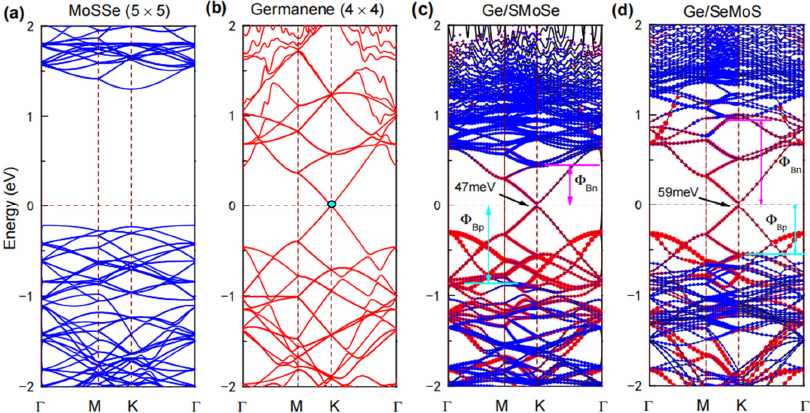
Figure 2. The band structures of ( a ) (5 × 5) MoSSe, ( b ) (4 × 4) germanene, ( c ) Ge/SMoSe and ( d ) Ge/SeMoS heterostructures. In Figure 2c,d, the contributions of MoSSe and germanene in the heterostructures are marked by solid blue and red circles, respectively.